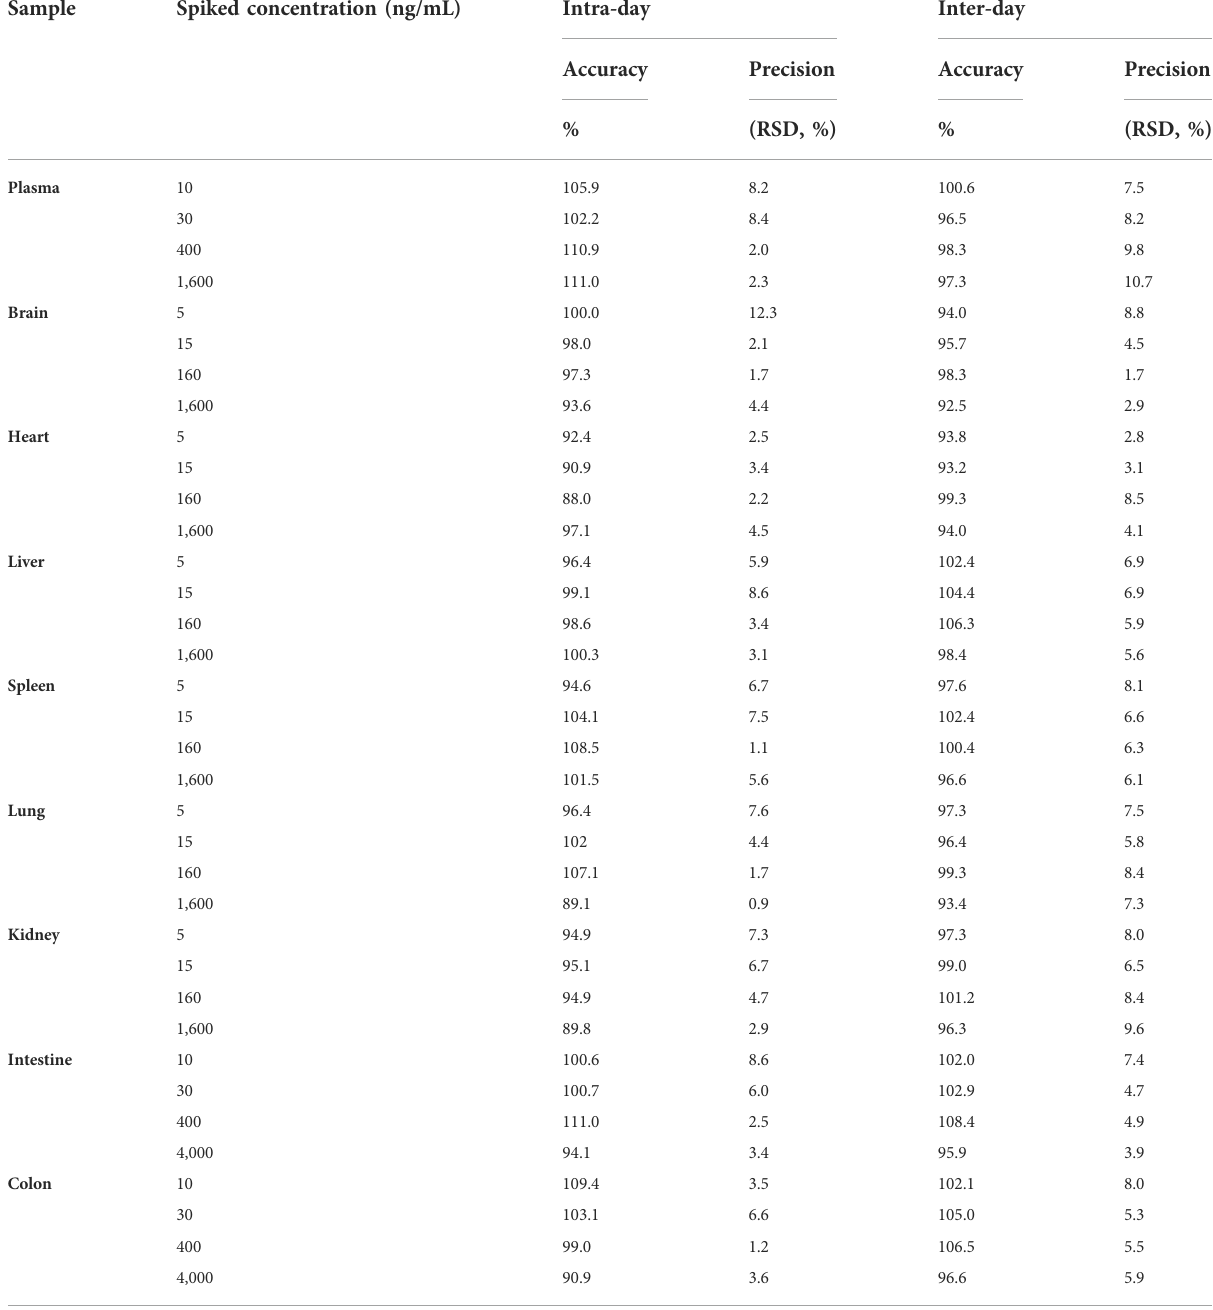
TABLE 2 Accuracy and precision of curcumol in rat plasma and tissue homogenates (n = 5). Sample Spiked concentration (ng/mL) Intra-day Inter-day